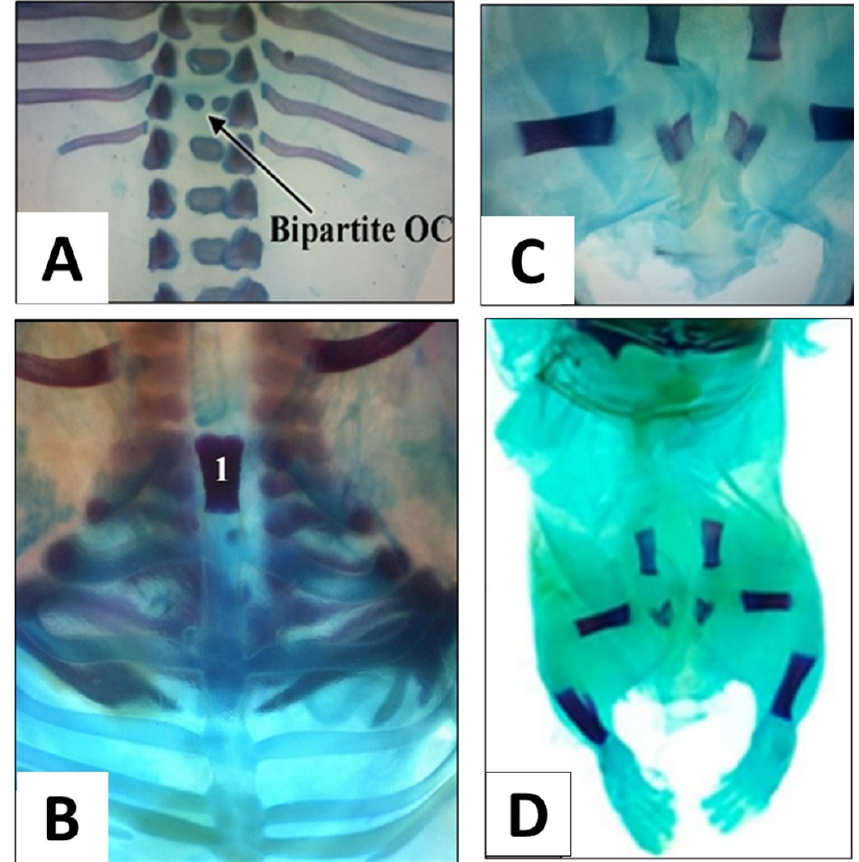
Figure 5. Photographs represent some of the observed skeletal abnormalities: Bipartite ossification centre (OC) of thoracic vertebra (found mostly in 500 mg/kg group) ( A ); Unossified sternebrae in a foetus of 250 mg/kg AHAE-treated group ( B ); sacrocaudal agenesis ( C ) and lumbar vertebrae agenesis ( D ) (250 mg/kg AHAE